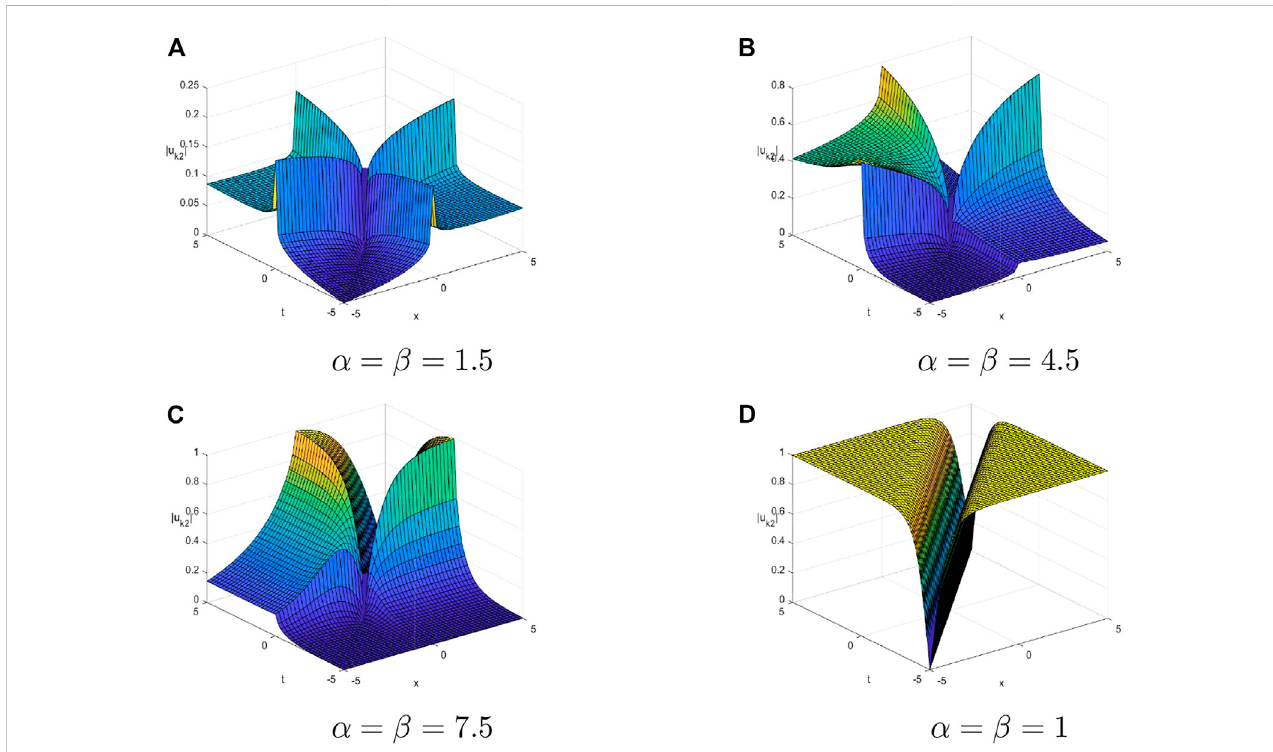
FIGURE 2 3DplotsofdarksolitonsolutionsfortheKerrlawnon-linearitywiththefourdifferentfractionalvaluesbyconsideringthevalues A 1 =1, B = − 1, v =1, κ = − 1, ω = 3, and δ = 1. (A) α = β = 1.5. (B) α = β = 4.5. (C) α = β = 7.5. (D) α = β = 1.